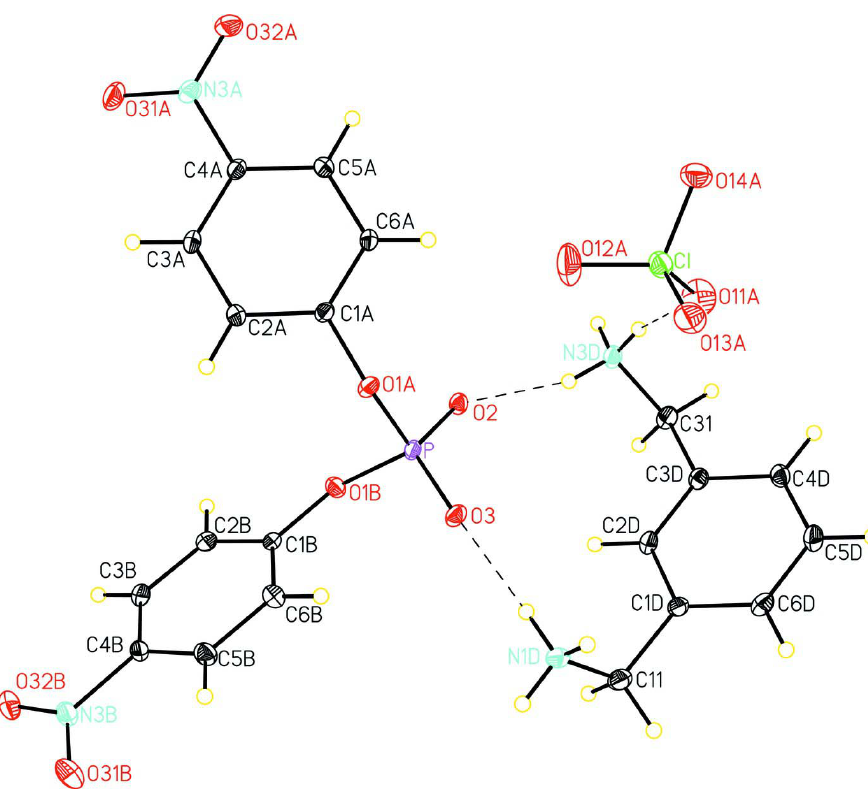
Figure 1 The title compound with numbering scheme used. Hydrogen bonding interactions shown as dotted lines. Ellipsoids are drawn at the 20% probability